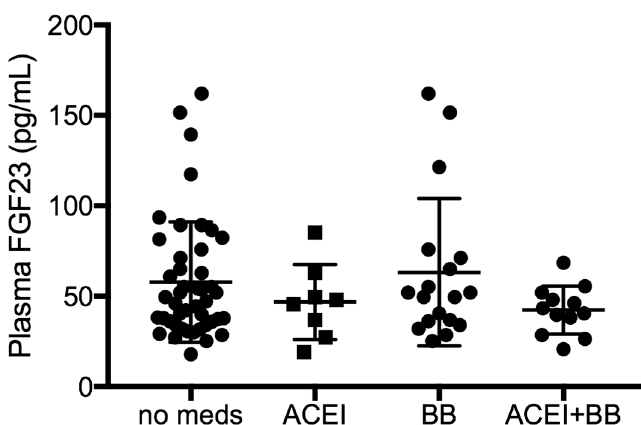
Figure 3. FGF23 levels in individuals with COPD, subgrouped according to their use of cardiovascular medication. Dot plot showing plasma FGF23 levels in individuals with COPD, who receive no cardiac medications (no meds), or regularly take ACE inhibitors (ACEI), beta blockers (BB) or both (ACEI + BB), showing no significant differences in FGF23 levels using multiple comparison ANOVA.